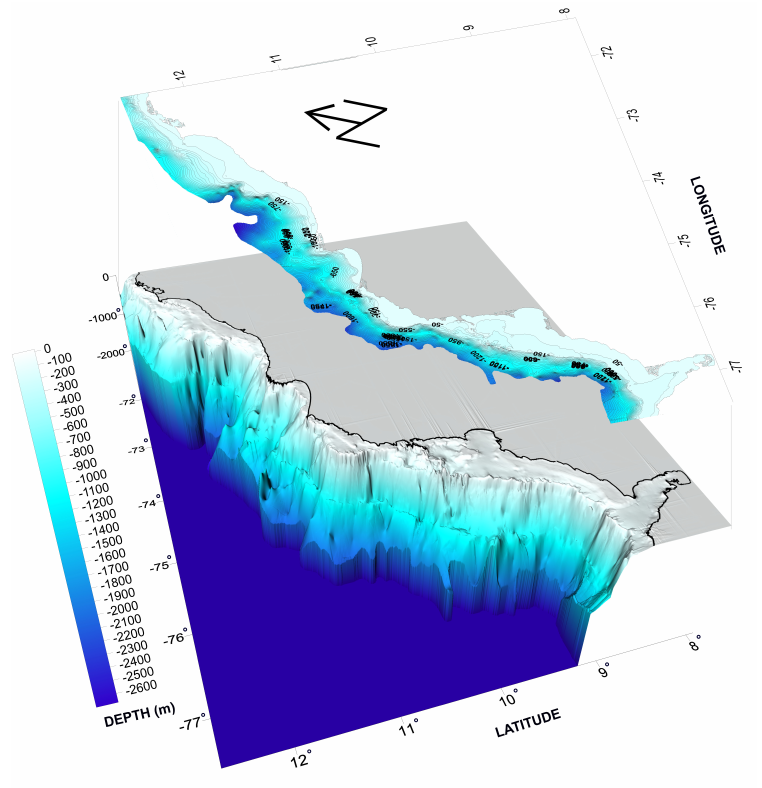
Figure 4. Bathymetry of the Colombian Caribbean.